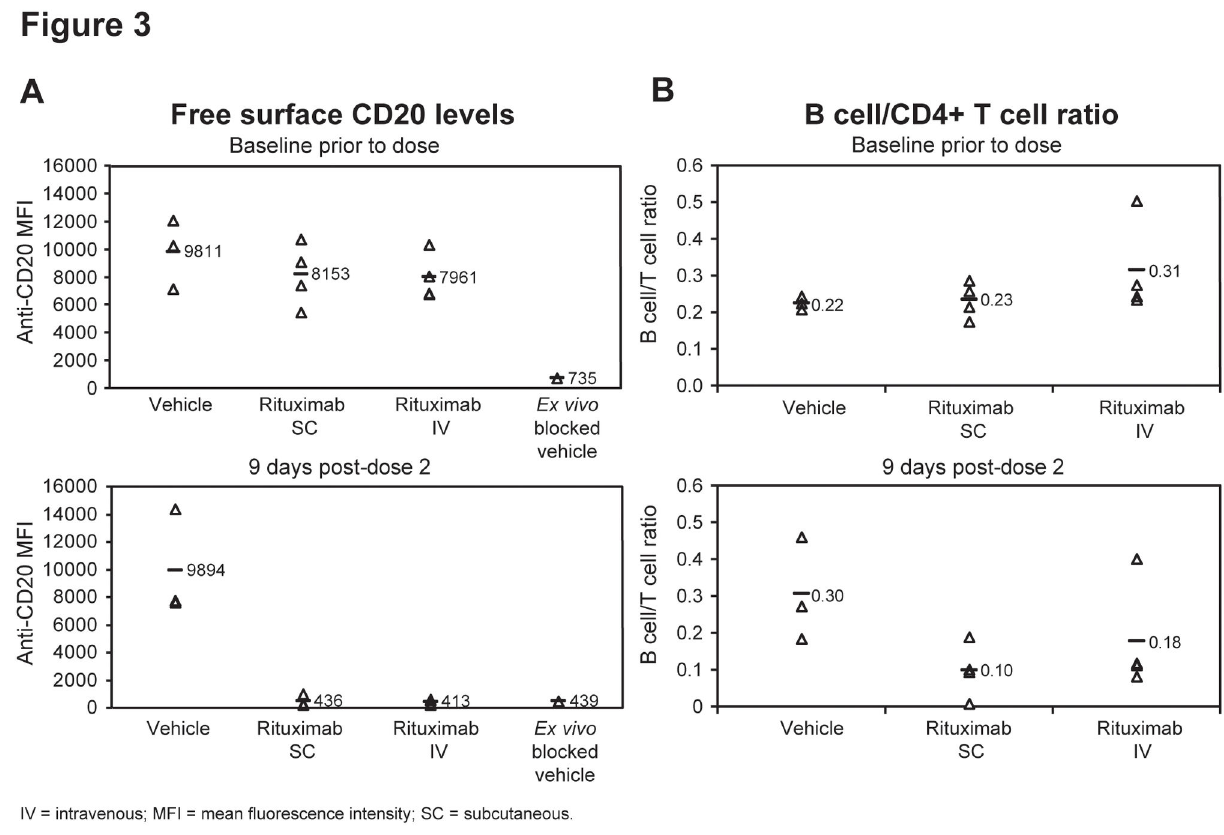
Figure 3. CD20 target coverage and B-cell depletion in lymph nodes. Lymph node analysis of ( A ) CD20 target coverage as determined by flow cytometric staining for free surface CD20 levels on (B cells identified as in Figure 2A) and ( B ) depletion of those lymph node B-cellsat baseline and 9 days after second dose of subcutaneous or intravenous rituximab as determined by a ratio to CD4+/CD3+ T cells (Individuals animal samples with mean shown (n=4 rituximab treated groups, n=3 PBS vehicle treated groups)).